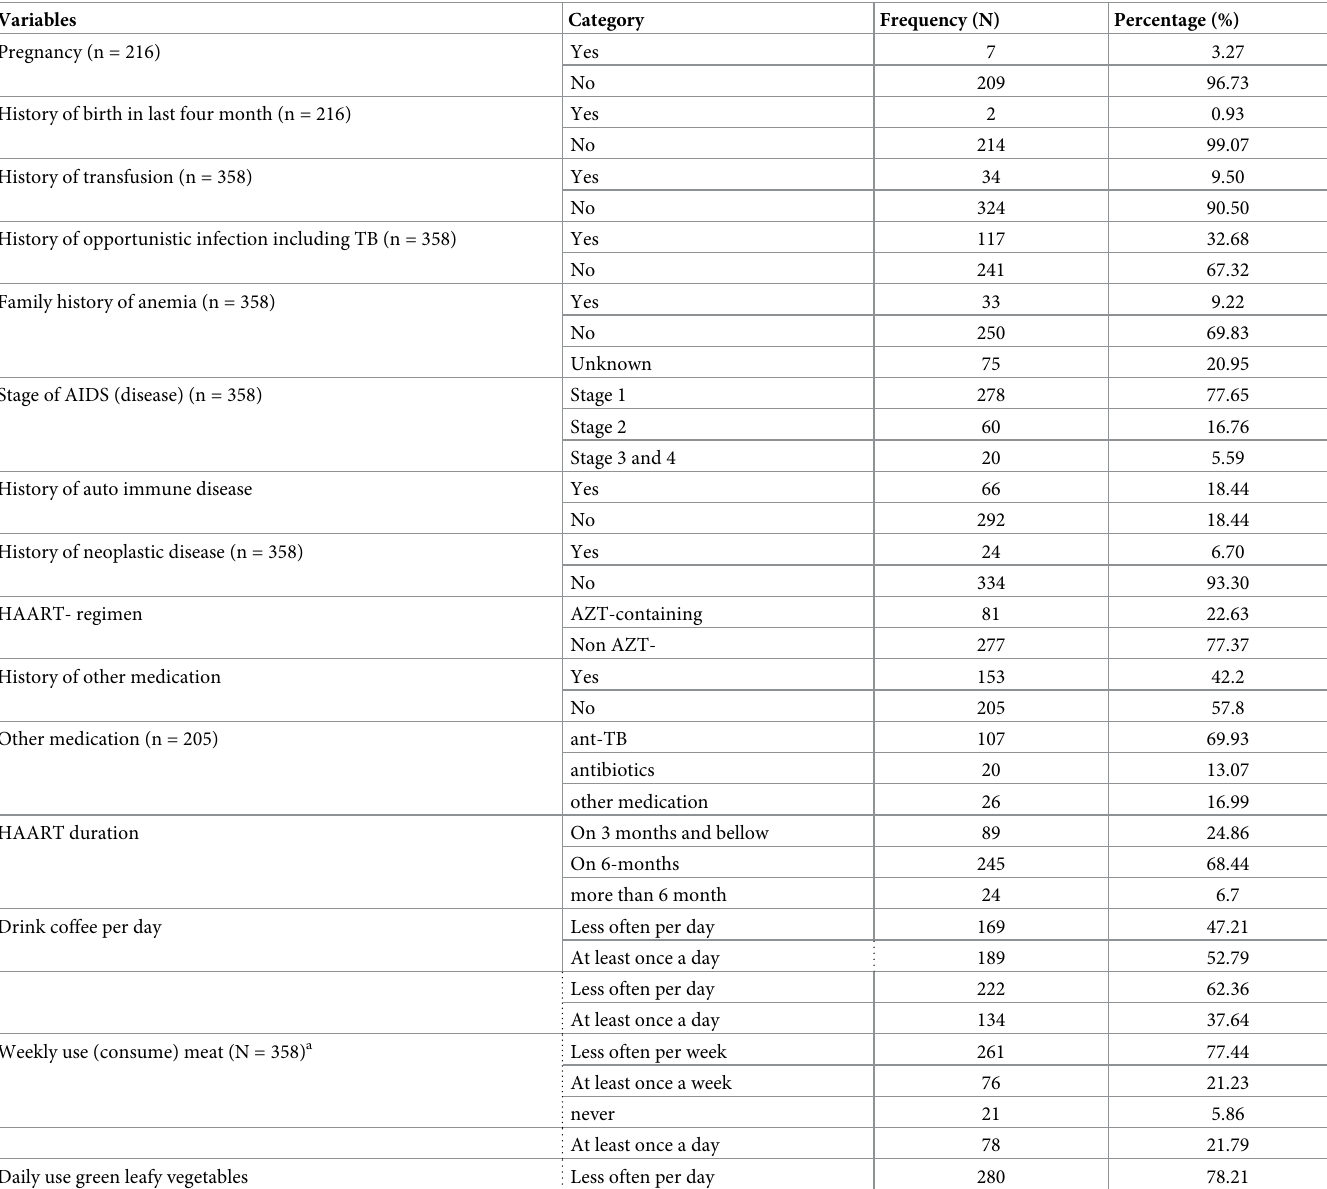
Table 2. Clinical characters of study participants for the magnitude of IHA and associated factors among HIV infected adults at UOGCSH from March to April 2021.